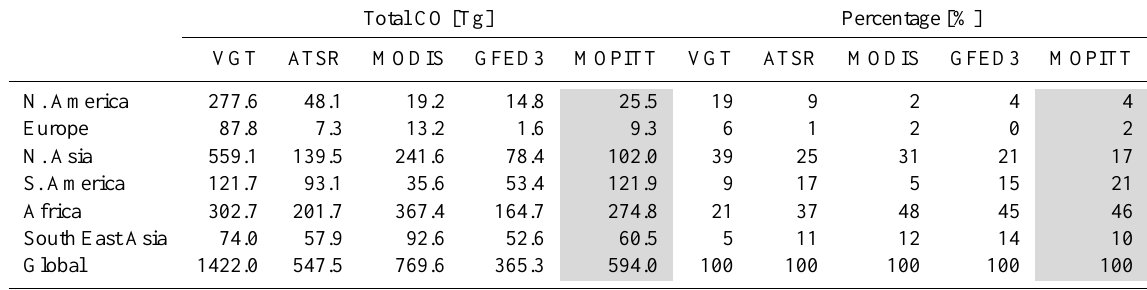
Table 2. Total CO emissions [Tg] for the globe and the continental windows and the percentage [%] computed with respect to the global totals. MOPITT values are highlighted in grey as it is the only top-down model.